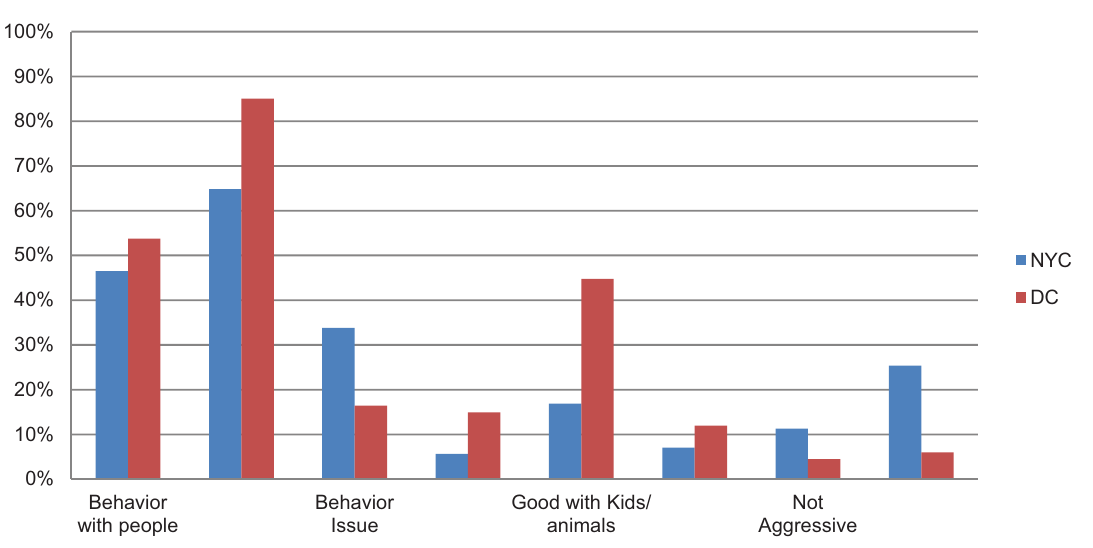
Figure 5. Comparison of information provided by relinquishers when asked, ‘what might help potential new adopters?’ in New York City and Washington,